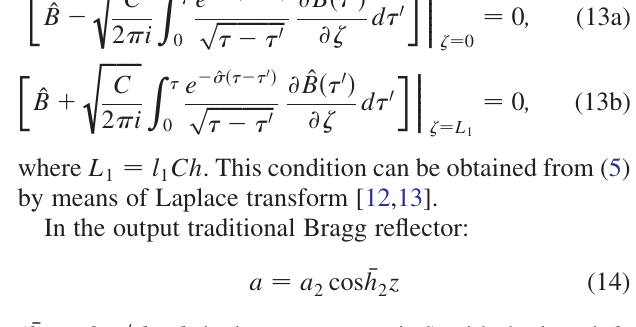
are the normalized output power radiated with the partial